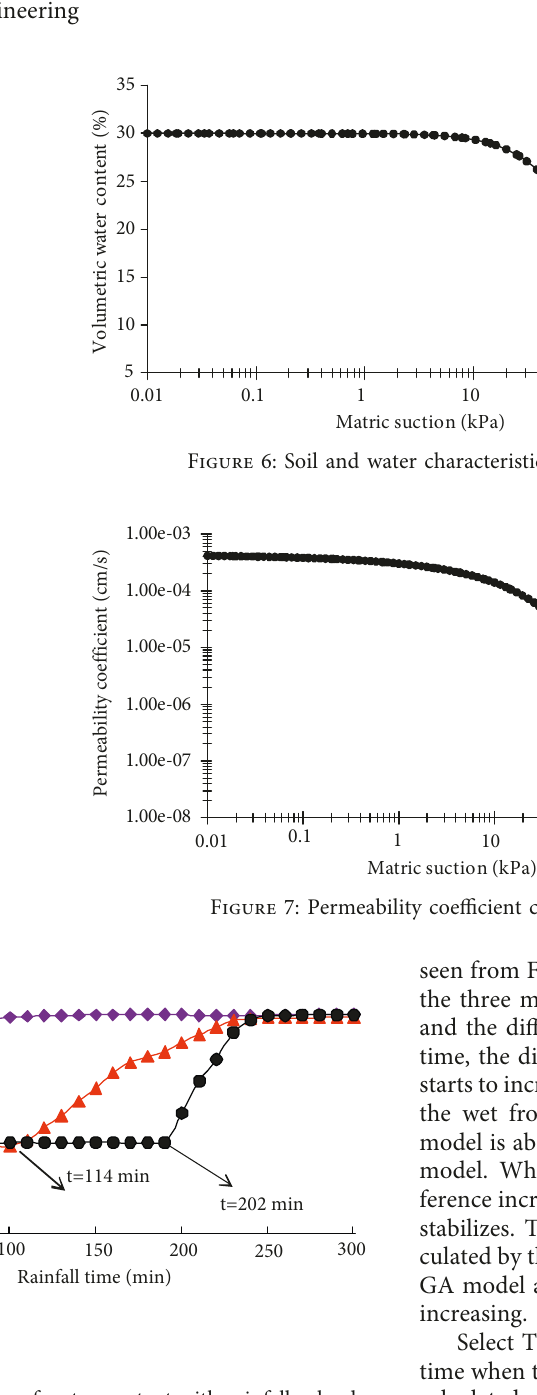
Figure 8: Variation curve of water content with rainfall calendar